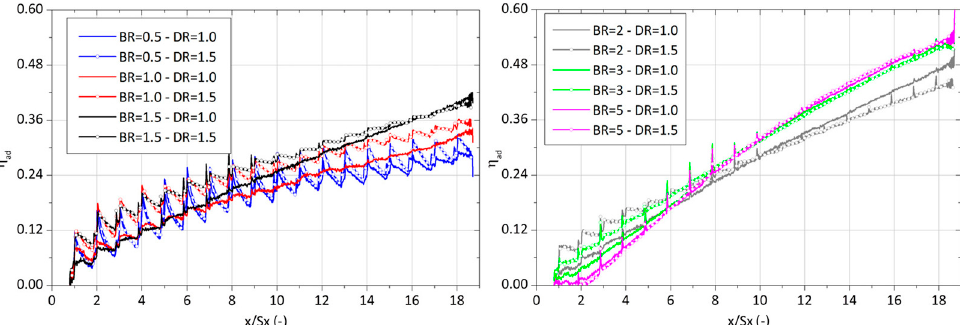
Figure 8. Effects of DR and BR on the lateral-averaged adiabatic effusion cooling efficiency. Reprinted with permission from [78]. Copyright 2014 ASME.